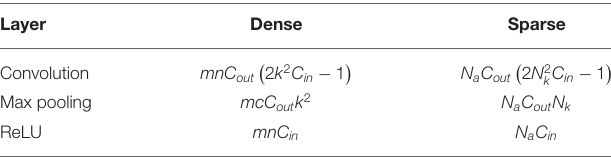
TABLE 5 | Comparison of the computational complexity of dense and sparse layers in terms of Floating Point OPerations (FLOPs). Layer Dense